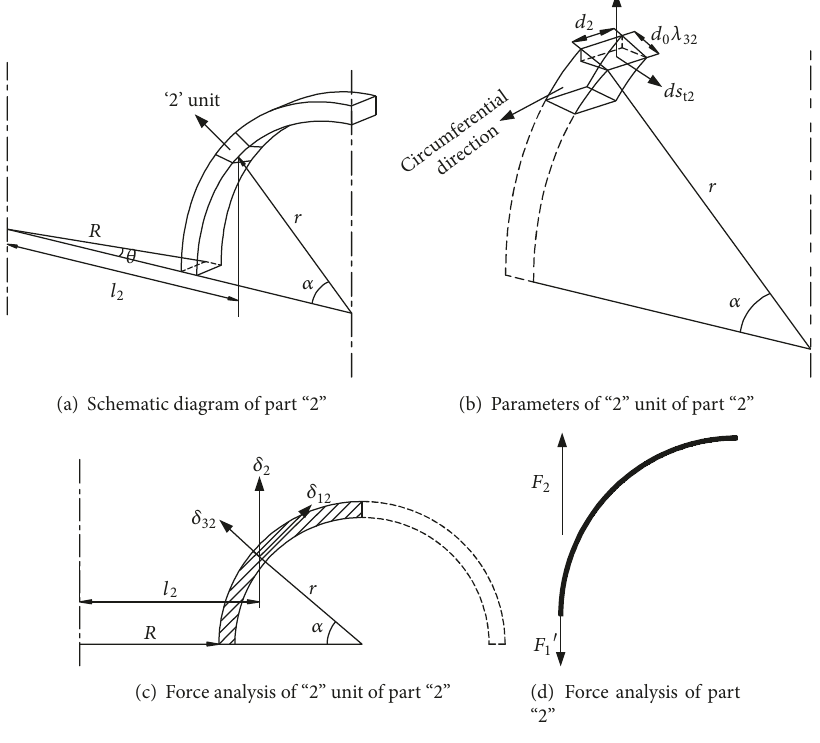
Figure 7: Force analysis of part “2” of the elastomeric diaphragm.